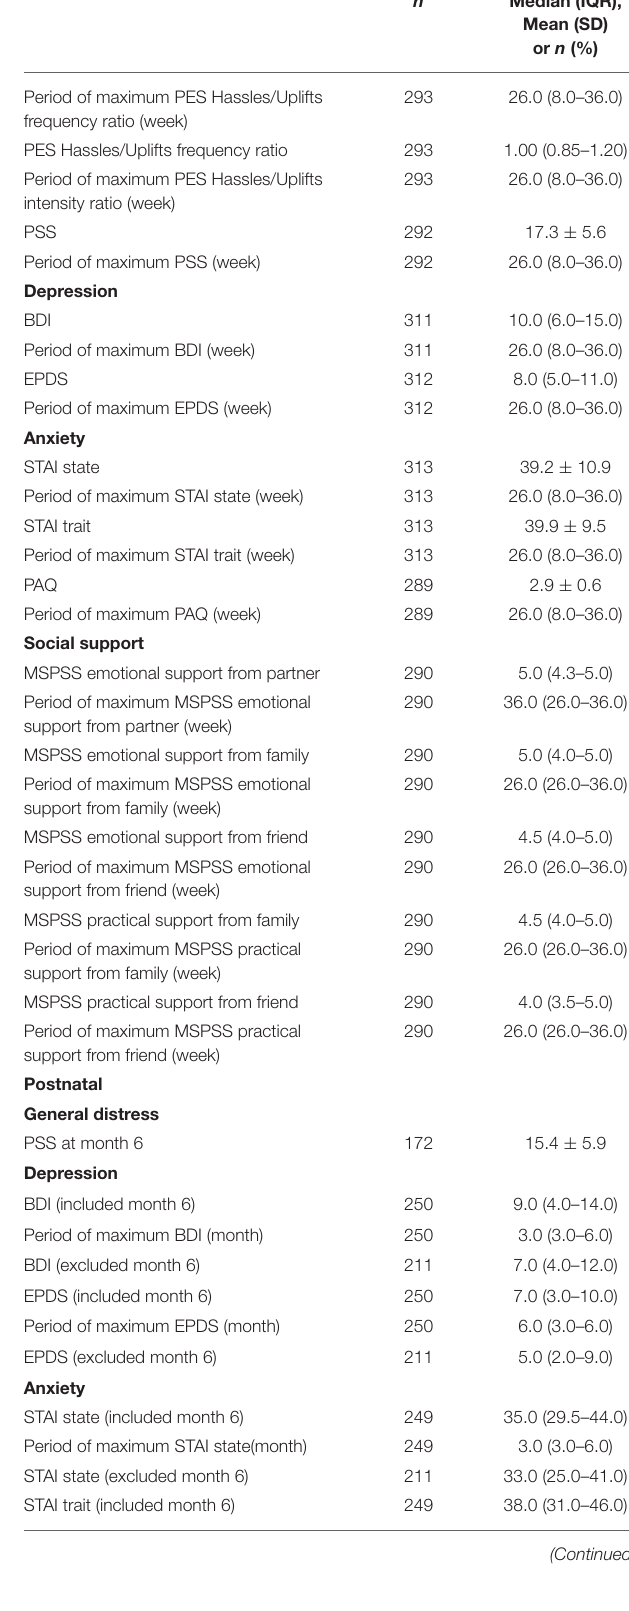
TABLE 1 | Characteristics of the study